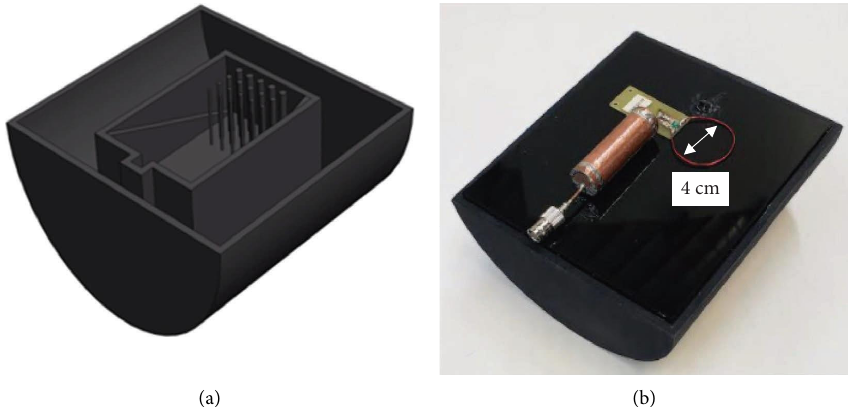
Figure 2: (a) CAD rendering of the phantom showing the inner structure with the rectangular food region with the ramps and pin cushion design for spatial localization and resolution quantifcation, respectively. (b) Photograph of the phantom with a single receive loop coil positioned on top.